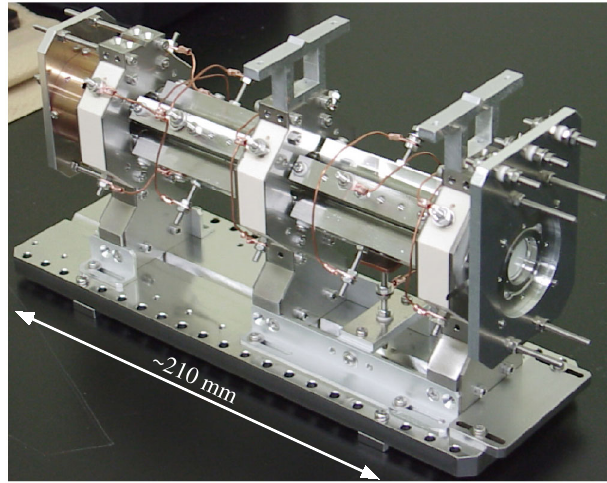
FIG. 1. The linear Paul trap used for the present experimental study of resonance